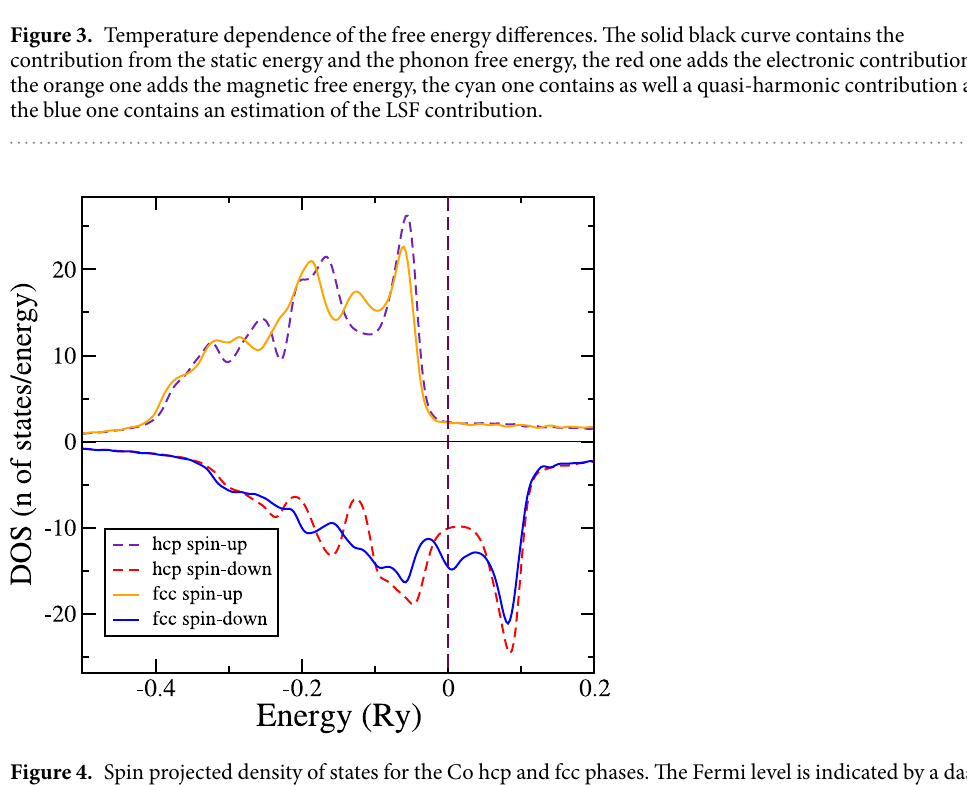
DOS are consistent with other DFT calculations 34 . This unusually large contribution of the electronic excitations has been encountered before, for example, in Fe-Mg alloys at Earth’s inner core conditions. In that work a similar effect is calculated for bcc and hcp Fe and explains why bcc Fe becomes dynamically unstable at core conditions 35 . Additionally, we investigated the electron-phonon interaction effects in the electronic entropy by following the analysis of Grimvall 33 and concluded that the effective contribution to the free energy is negligible in the case of cobalt. The next contribution to the free energy in Eq. 1 comes from the magnetic system. In order to obtain the finite-temperature magnetic properties of Co beyond the DLM estimate in Fig. 1 we performed standard Monte Carlo calculations of a Heisenberg Hamiltonian with fixed-size magnetic moments by means of the Metropolis algorithm 36 . The calculated Curie temperatures are 1249 K for hcp and 1228 K for fcc Co. The contribution of the magnetic free energy can be seen in Fig. 3 (orange solid line). Our results show that the magnetic free energy